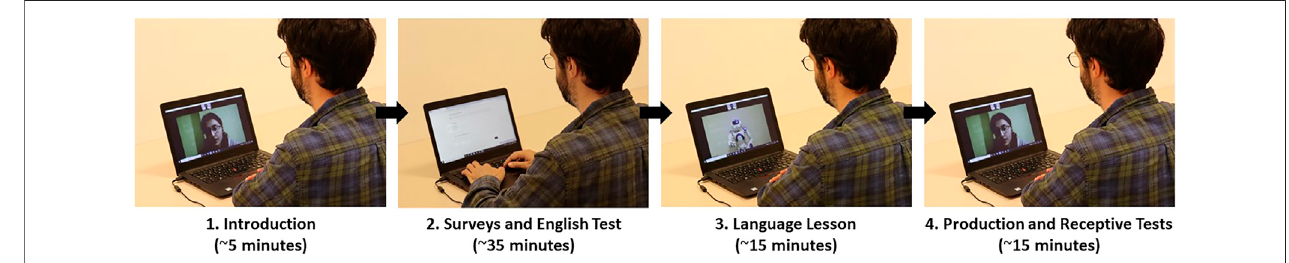
FIGURE 1 | The procedure of the lesson from the participant ’ s perspective. In the voice-only tutor condition, the voice sound spectrum appeared instead of the robot (see Figure 2 and Supplementary Material ). Step 4 (Production and Receptive Tests) was repeated one week later.